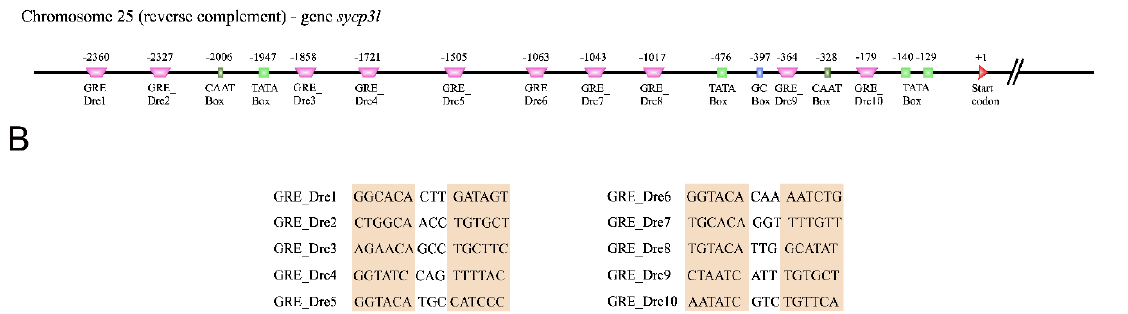
Figure 6. Schematic positions of predicted glucocorticoid response elements (GRE) upstream of the zebrafish sycp3l gene. ( A ) The nucleotide numbering was orientated according to the start codon ( + 1). Sequences of the Danio rerio GREs are indicated as Dre (purple trapeze). Green squares represent the TATA-Box; light green rectangles represent the CAAT-Box; blue rectangles represent the GC-Box. ( B ) Putative predicted GRE sequences (GRE_Dre1 to GRE_Dre10) located upstream of the zebrafish sycp3l gene, half 3 ′ and half 5 ′ of the GRE sequences were represented by salmon colored boxes.